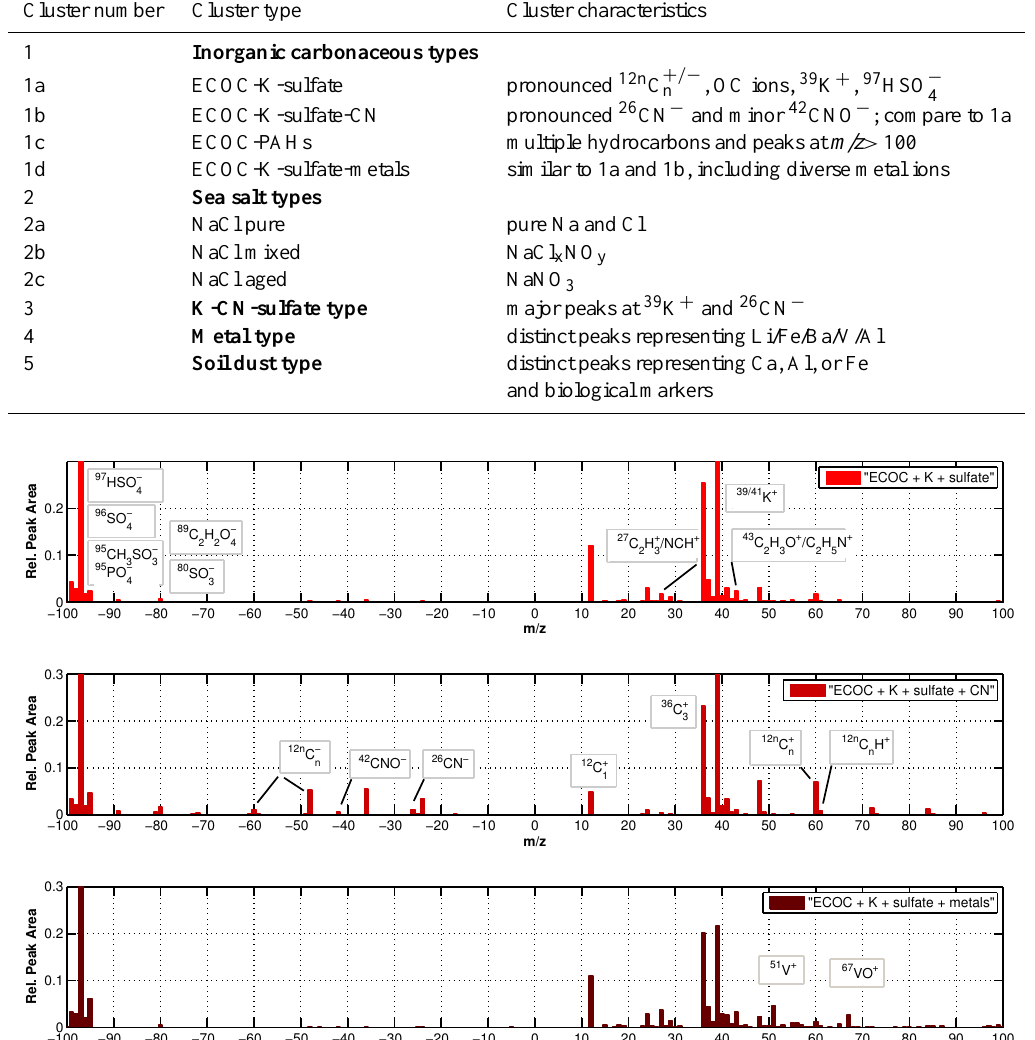
Table 1. Most prominent particle types obtained using ENCHILADA and ART-2a. Bold-face letters mark the main aerosol types.